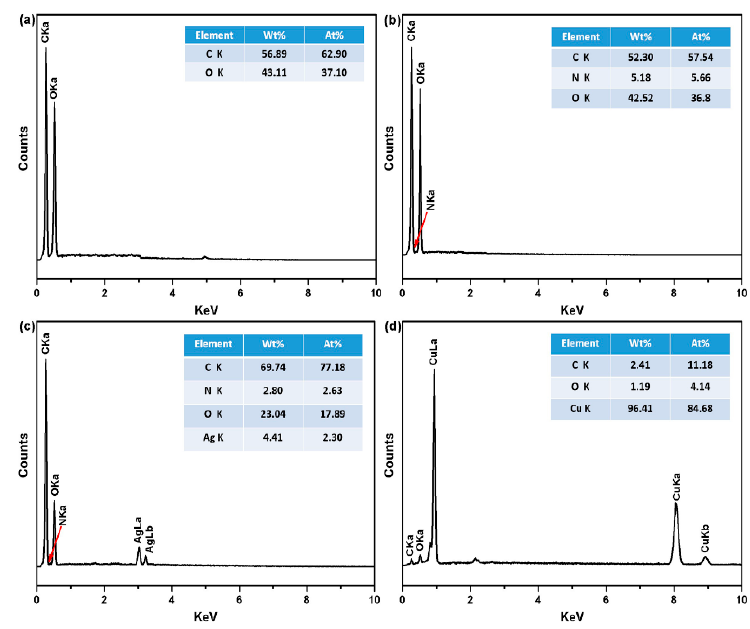
Figure 6. Energy dispersive X-ray spectroscopy (EDS) spectra of ( a ) original PET fabrics; ( b )PDA / PET fabrics; ( c ) Ag/PDA/PET fabrics; and ( d ) Cu/Ag/PDA/PET fabrics.